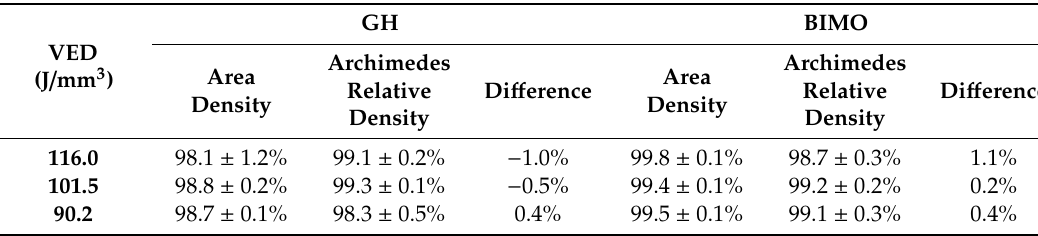
Figure 5. ( a , b ) As-polished and ( c , d ) etched optical micrographs obtained from parallel cross-sections of ( a , c ) GH single-mode powder, and ( b , d ) BIMO bimodal powder, each SLM-manufactured at a VED of 101.5 J / mm 3 ; ( e ) Annealed and etched GH sample SLM-manufactured at 73.8 J / mm 3 ; ( f ) Annealed and etched BIMO sample SLM-manufactured at 89.0 J / mm 3 . Table 3. Density values measured from area percent porosity based on analysis of optical micrographs of samples cut parallel to build direction and density values measured from the Archimedes method for parts made from single-mode GH powder and bimodal powder BIMO (parts were SLM-manufactured at VED of 90.2, 101.5 and 116 J / mm 3